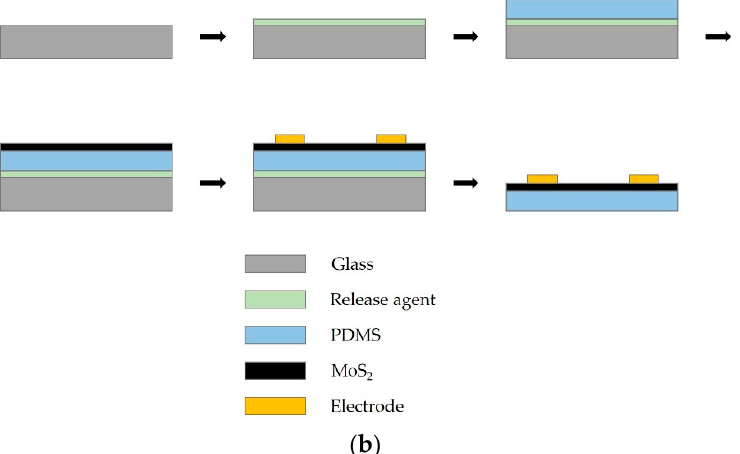
Figure 11. The schematic of the MoS 2 film pressure sensor and its processing flow: ( a ) the MoS 2 thin film pressure sensor; ( b ) Production process of MoS 2 film pressure sensor.